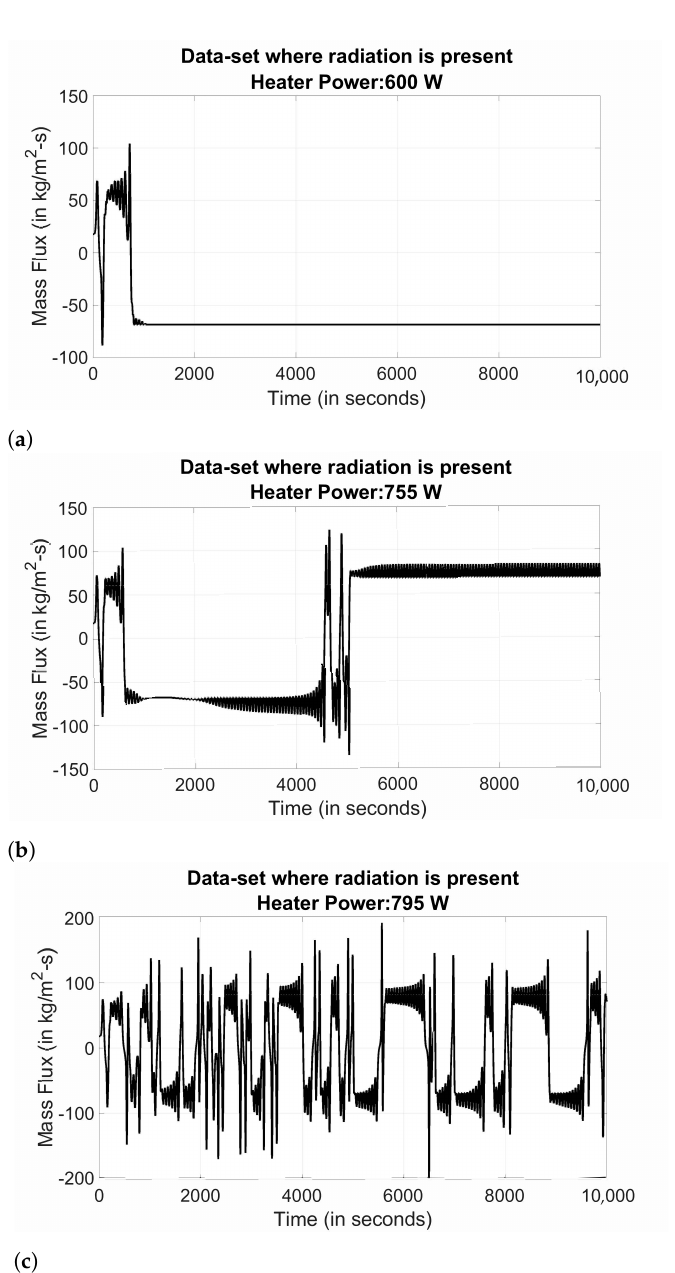
Figure 3. Sample mass flux variation time series in the presence of radiation heat loss for ( a ) Steady-state, ( b ) Oscillatory, and ( c ) Flow-reversal